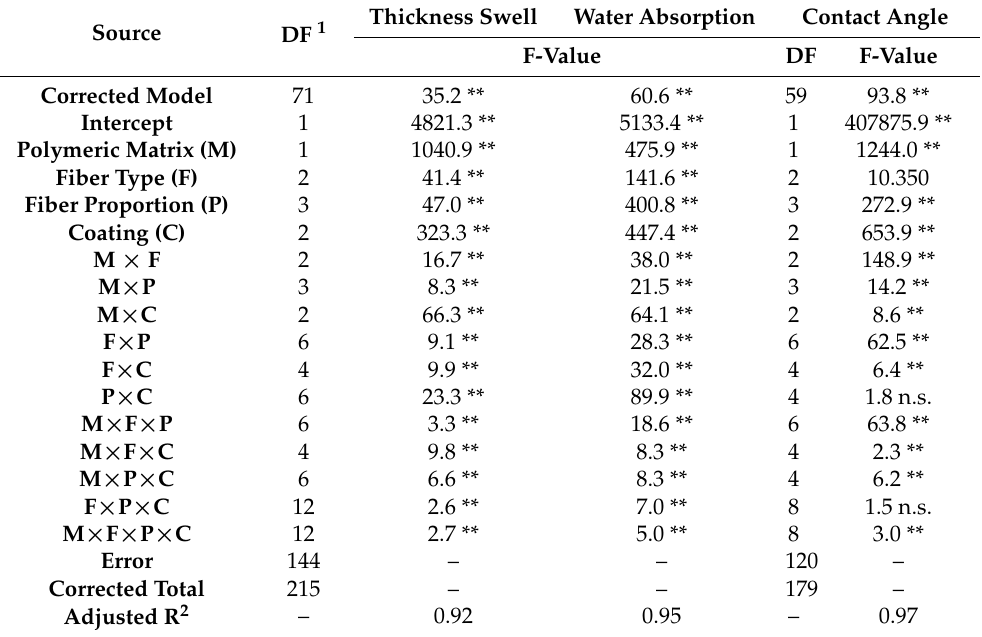
Table 2. Analysis of variance, with F-values for the studied factors (Polymer type, fiber type, fiber proportion, coating type, and their interactions), and their significance, for thickness swell, water absorption, and composites contact angle after water